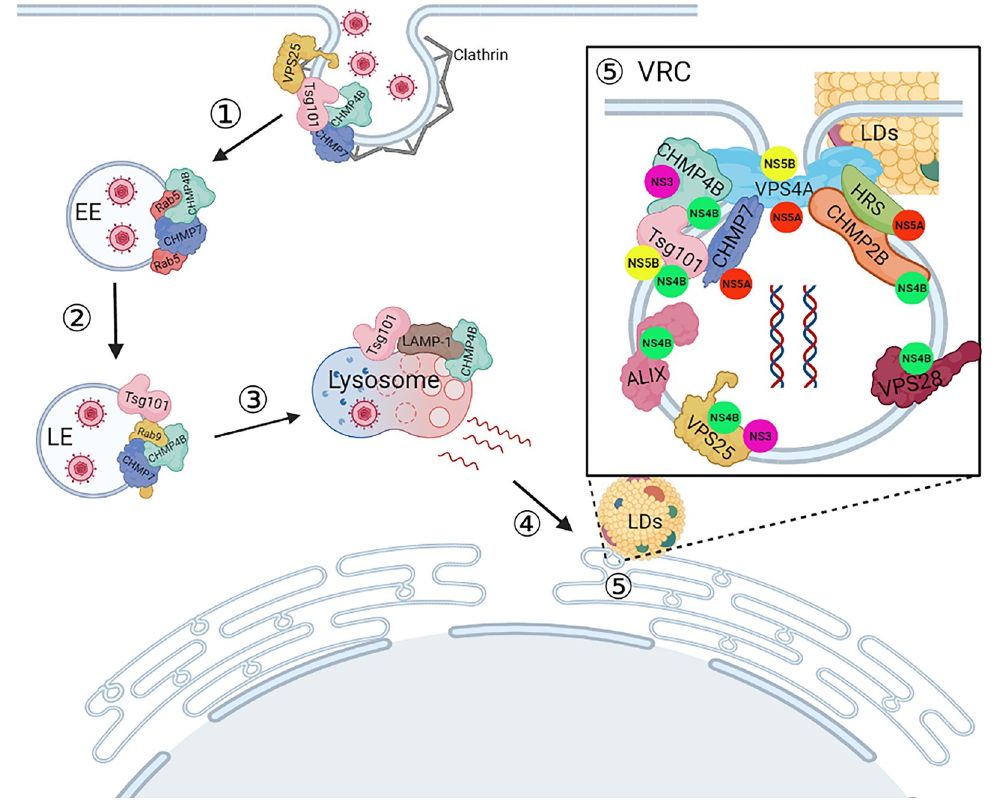
Fig 11. Schematic model depicting CSFV life cycle and the role of ESCRT proteins in PK-15 cells. (1) Clathrin interacted with Tsg101, VPS25, CHMP4B and CHMP7 proteins upon CSFV entry, then transported to the early endosomes. (2) In the early endosomes, CHMP4B and CHMP7 proteins interacted with Rab5 protein and assist the transport of CSFV to the late endosomes. (3) In the late endosomes, Tsg101, CHMP4B, and CHMP7 proteins interacted with Rab9 protein and transport CSFV to the lysosomes. (4) Later, in the lysosomes, the Tsg101 and CHMP4B proteins interacted of with LAMP-1 leads to uncoating and released nucleic acid, then transported to the endoplasmic reticulum area. (5) Finally, ESCRT proteins interacted with nonstructural proteins of CSFV and formed a virus replication complex (VRC) in the ER lumens for viral genome replication. Finally, LDs were closed to the VRC and connected by VPS4A